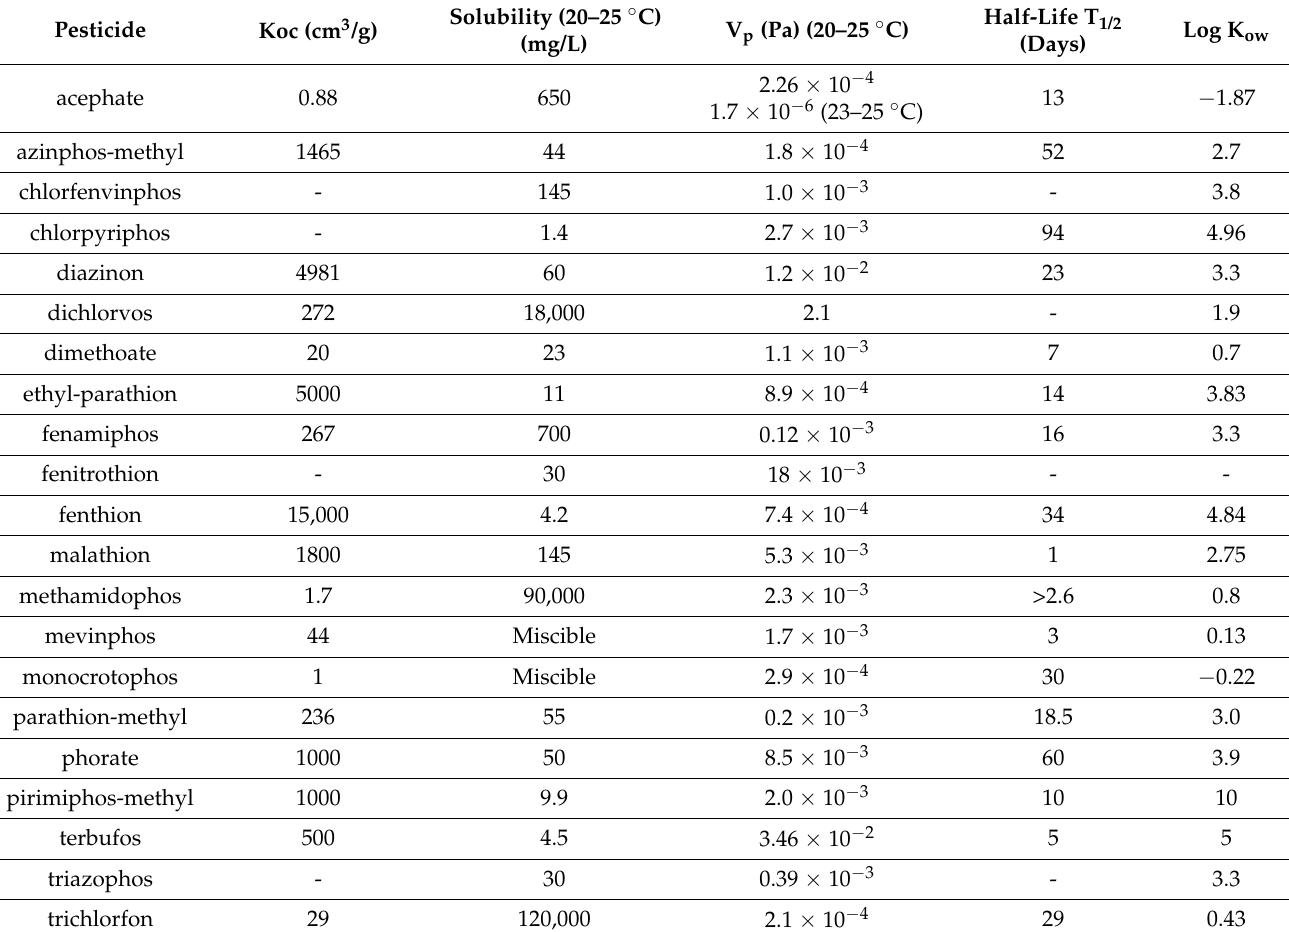
Table 3. Physicochemical properties of organophosphate pesticides [19–21].